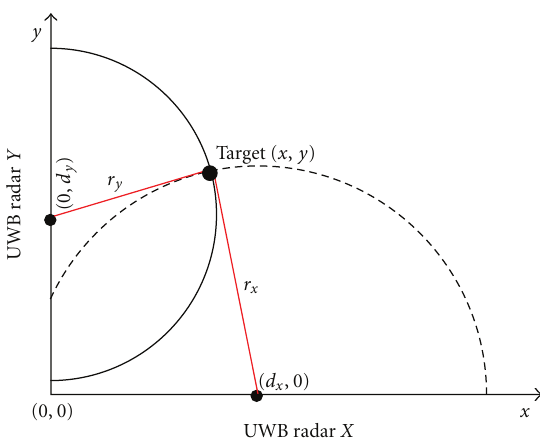
Figure 8: Setup for 2-dimensional